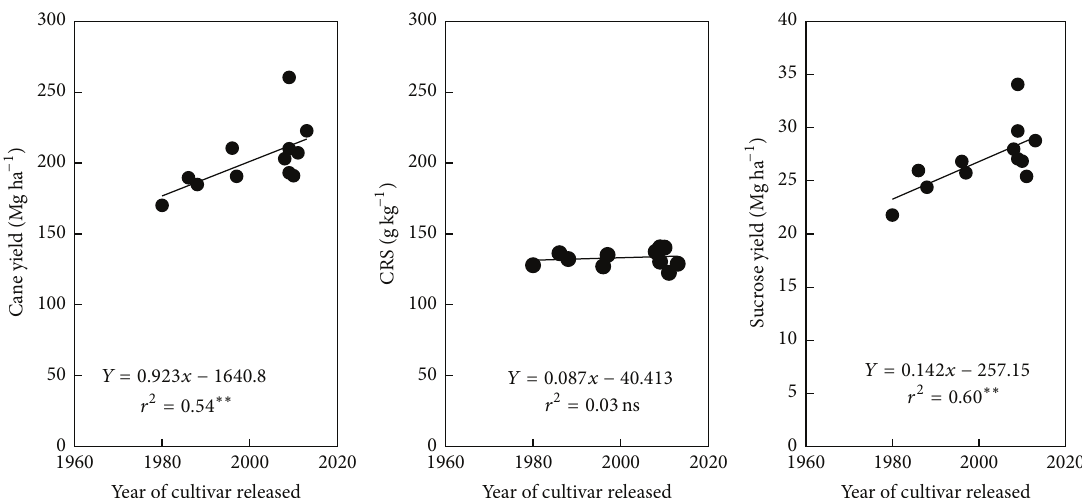
Figure 3: Trends of cane yield, commercial recoverable sucrose (CRS), and sucrose yield for 12 sugarcane cultivars or genotypes grown on sand soils at two locations in Florida. These cultivars had a wide range of released years from 1980 to 2013.